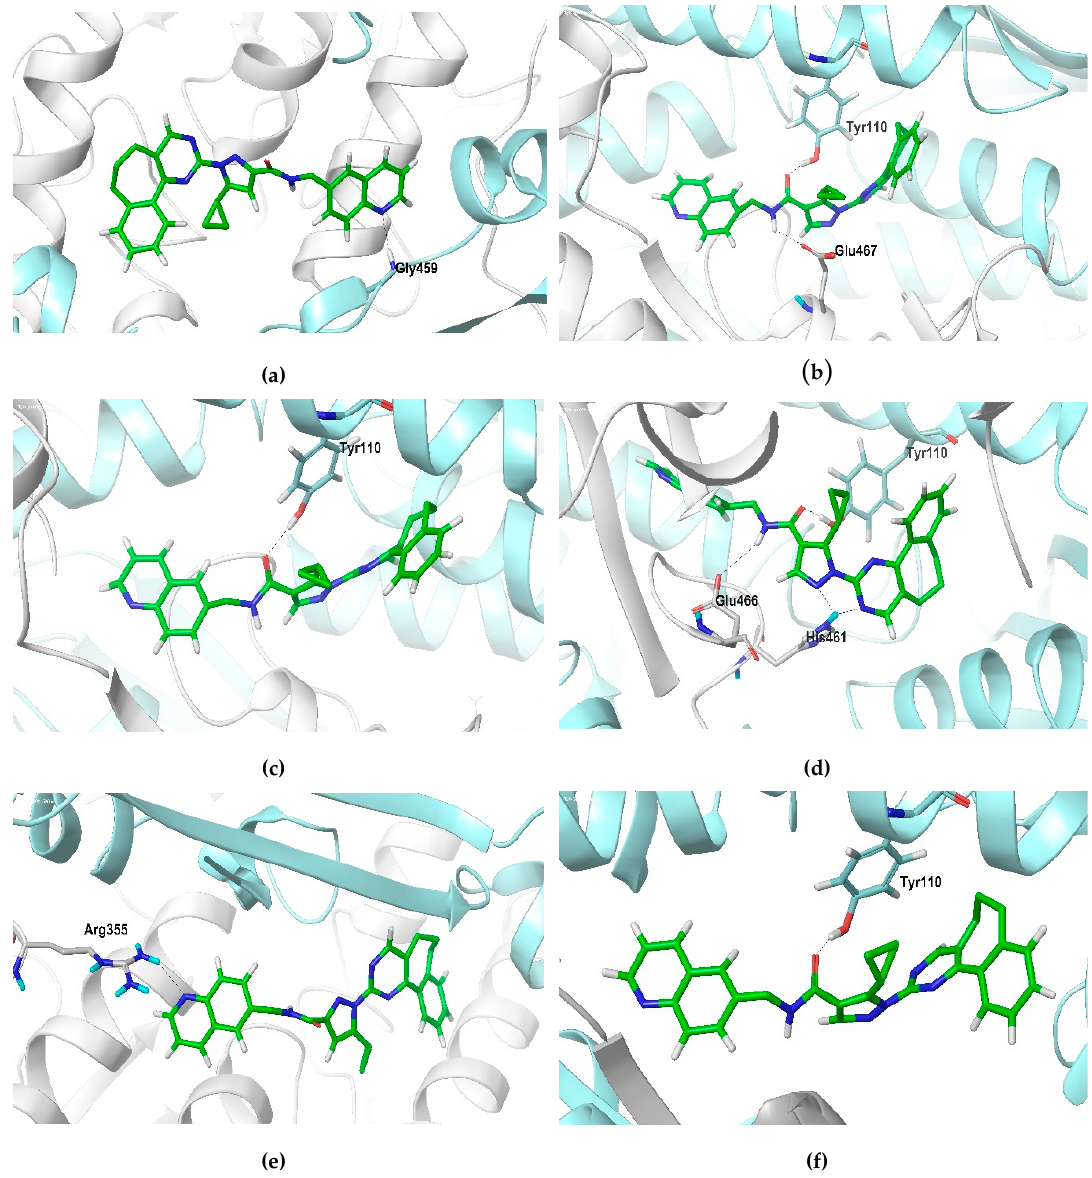
Figure 7. The hydrogen bonding interactions of compound ZINC12151998 with LmTR at 10 ns ( a ), 20 ns ( b ), 30 ns ( c ), 40 ns ( d ), and 50 ns ( e , f ). The LmTR monomers A and B are represented with gray ribbons and cyan ribbons, respectively. Carbon skeleton of compound ZINC12151998 is presented in green sticks, oxygen atoms are in red, nitrogen atoms are in blue, and hydrogen atoms are in grey. H-bonds are depicted as dotted lines.